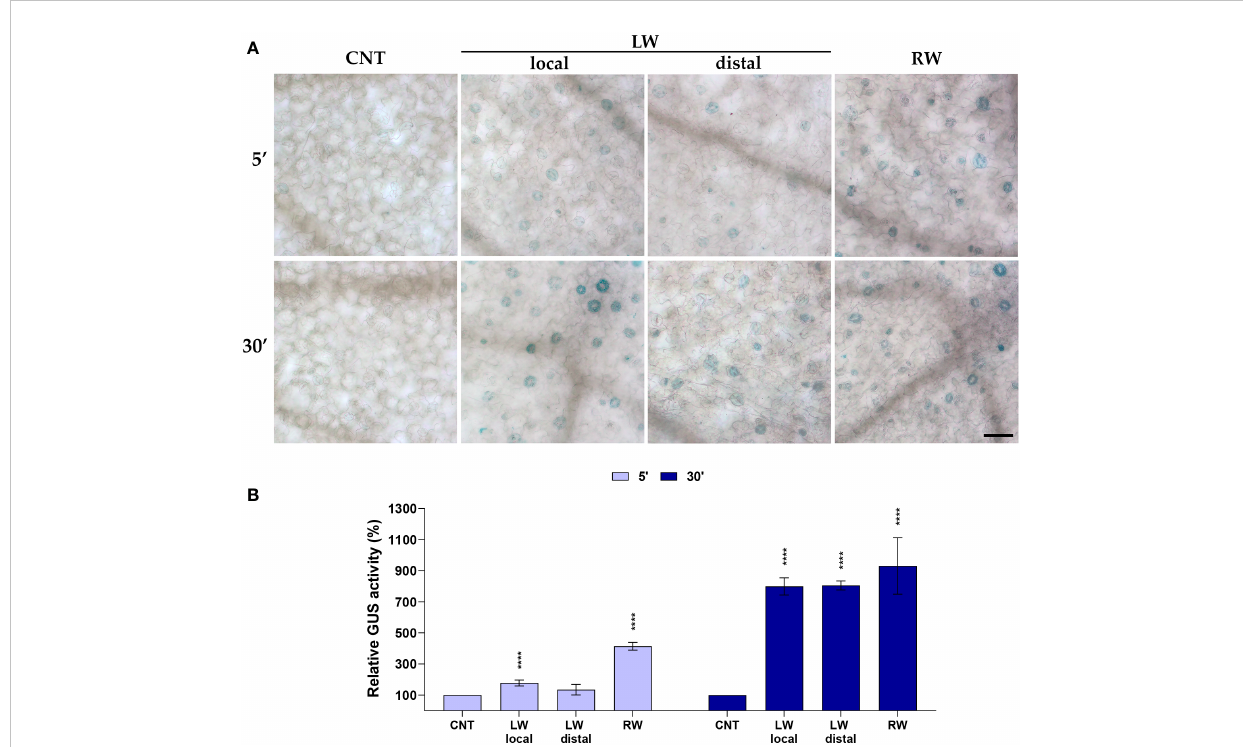
FIGURE 2 Analysis of AtCuAO b tissue-speci fi c expression pattern after cotyledonary-leaf or root wounding. Light microscopy analyses of GUS staining were carried out in 7-day-old AtCuAO b -promoter::GFP-GUS transgenic seedlings. Stomata of control unwounded cotyledons (CNT), wounded cotyledons (LW local), distal unwounded cotyledons (LW distal) and cotyledons of root wounded seedlings (RW) were observed after 5 and 30 min from the onset of injuries. The staining reaction proceeded for 40 min. Micrographs are representative of those obtained from fi fteen leaves from three independent experiments (A) . Quanti fi cation of changes in GUS activity in guard cells (B) . Mean values ± SD ( n = 45) are reported. Signi fi cance levels between unwounded control seedlings (CNT) and wounded seedlings (LW, RW) are reported. p levels have been calculated with the t-test analysis; p levels > 0,05; **** p levels ≤ 0,0001. If not shown, the statistical difference is not signi fi cant. CNT, control; LW, leaf wounding; RW, root wounding. Bar = 50 m